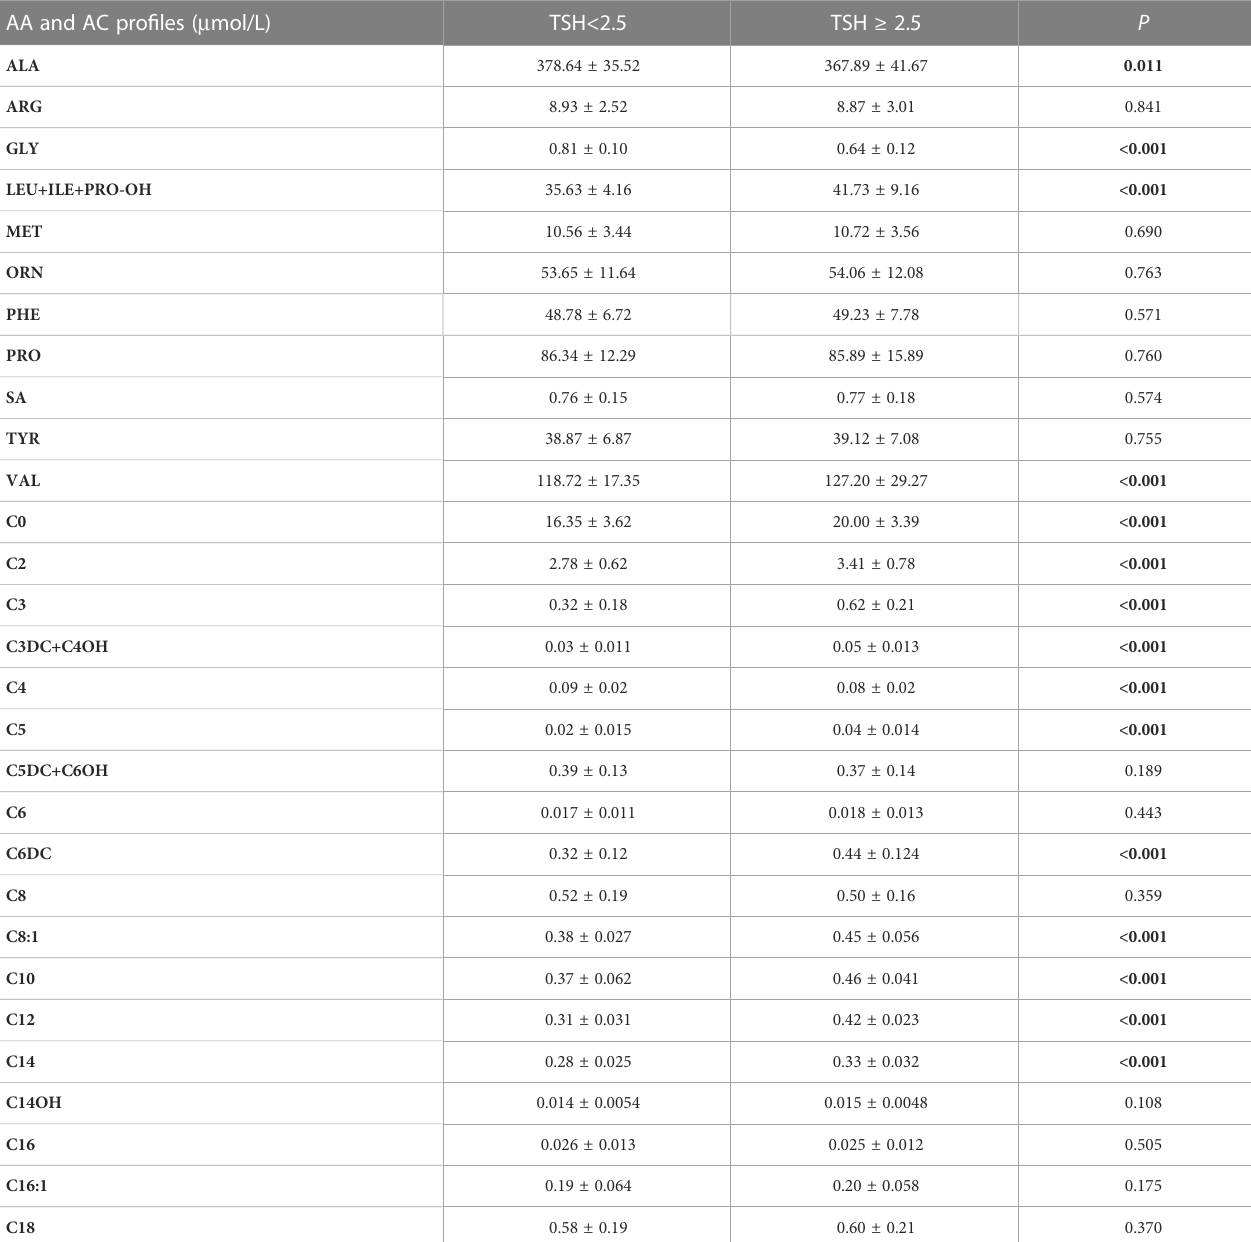
TABLE 4 Thirty-one carnitine-related metabolites by TSH (n = 844). AA and AC pro fi les ( m mol/L)